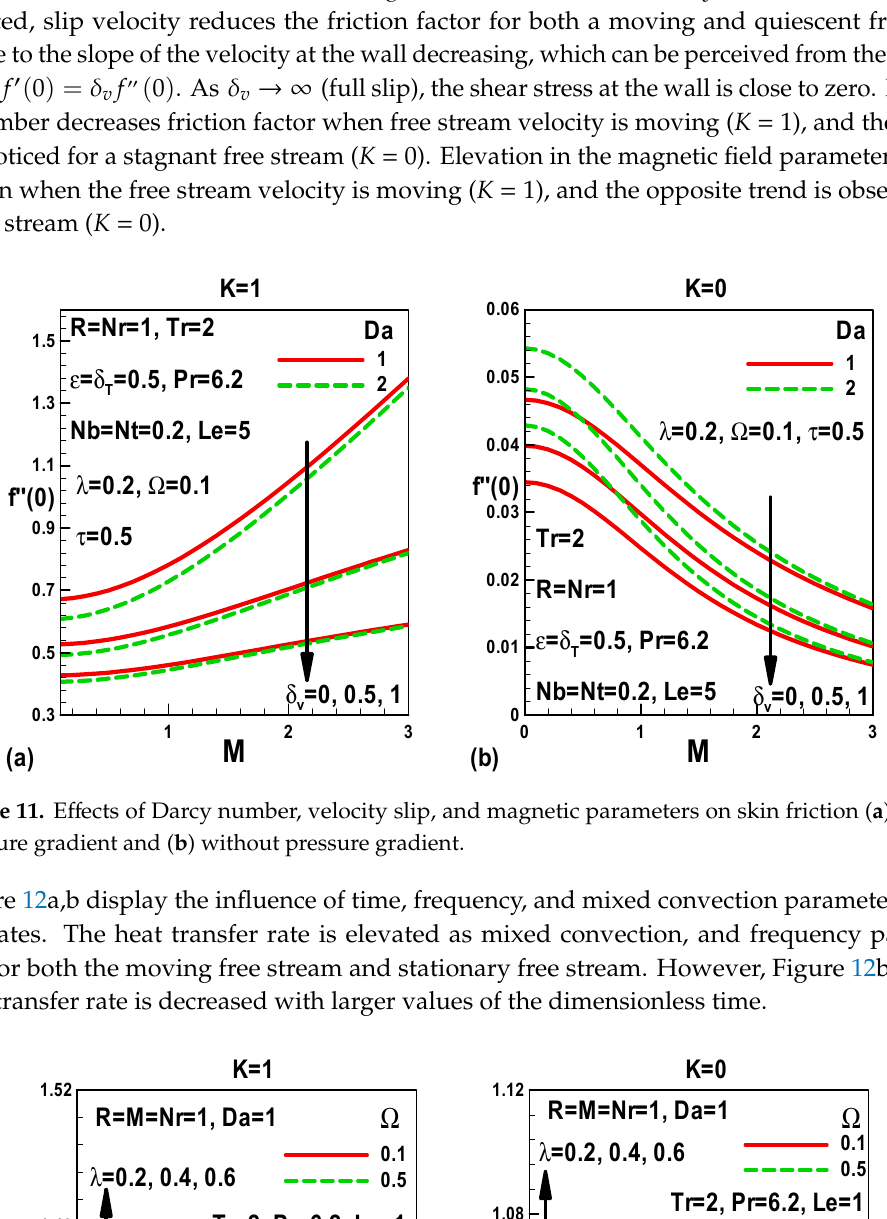
Figure 10. Effects of dimensionless time, frequency, and mixed convection parameters on skin friction ( a ) with pressure gradient and ( b ) without pressure gradient.